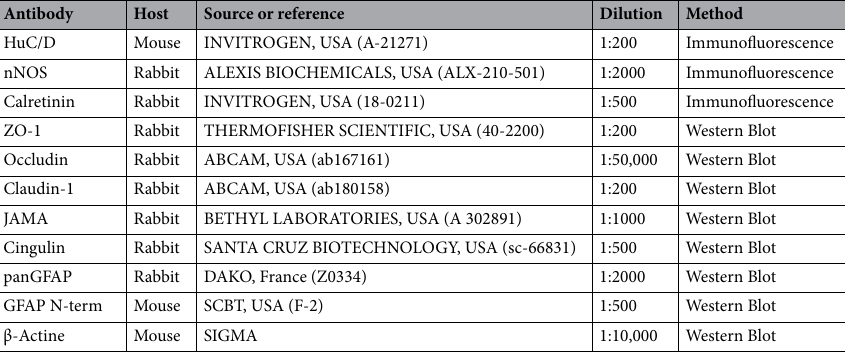
Table 2. Primary antibodies. HuC/D human neuronal protein, nNOS neuronal nitric oxide synthase, GFAP glial fibrillary acidic protein.